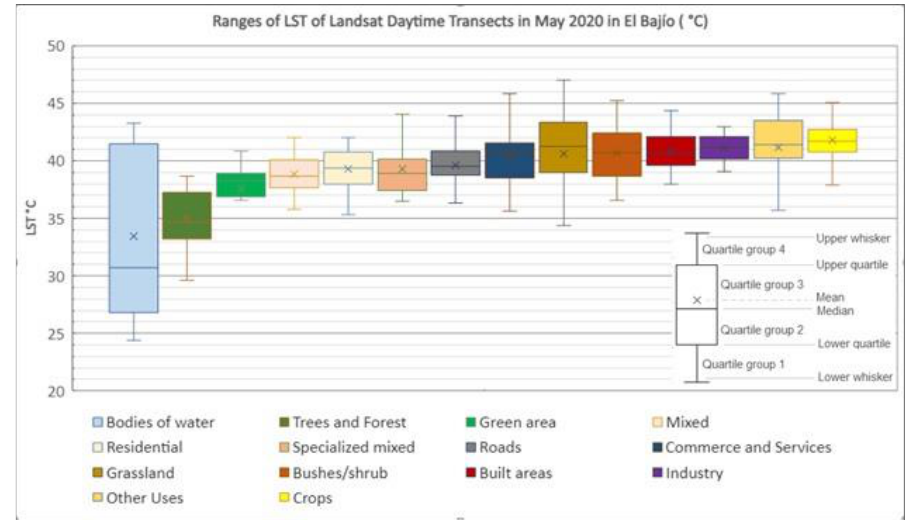
Figure 9. Boxplots showing ranges of LST of Landsat Daytime Transects in May 2020 in El Bajío (°C), the values are sorted by mean in ascending order.